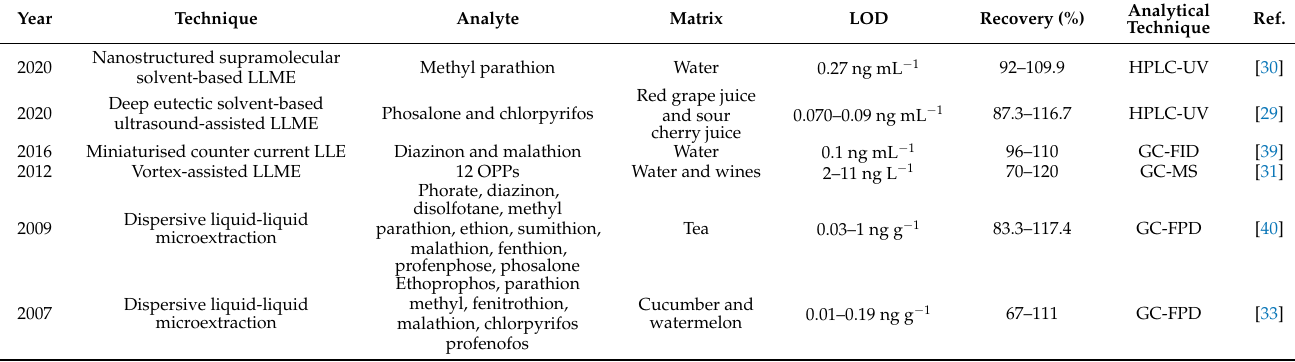
Table 3. Summary of past studies on the application of LLE as a sample preparation technique for OPPs’